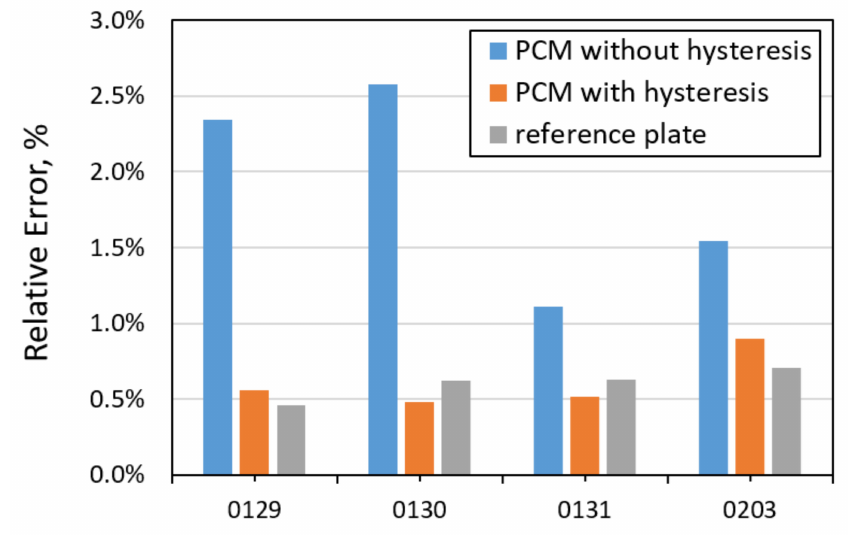
Figure 8. Mean error of surface temperature estimation in four cycles of